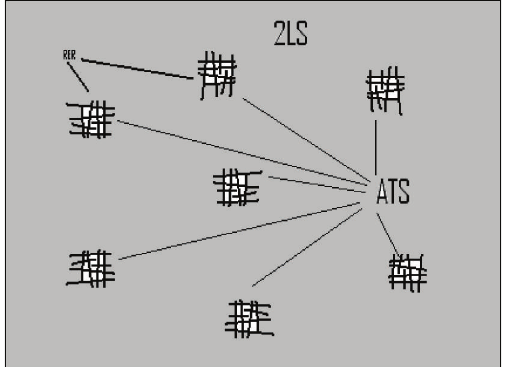
Figure 6: A 2D cartoon of the chocolate-like, ceramic-glass struc- ture of a real glass, in which partial devitrification has occurred, with thelocationofitslow- 𝑇 ,two-speciesTS.Intherandomlynetworked bulk of the material sit the STM-2LS, with their own concentration 𝑥 2 LS , whilst within and in the proximity of the incipient crystallites nest the ATS, with their own bulk concentration 𝑥 described by (3) and (6). We expect 𝑥 in the best